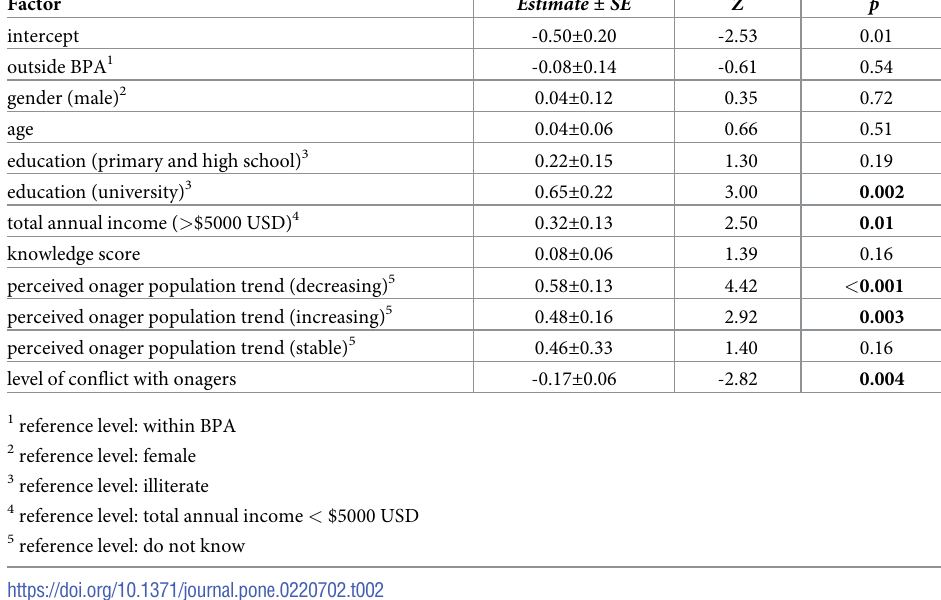
Table 2. Parameter estimates of factors influencing perceived value of onagers resulted from a beta regression model (pseudo R 2 = 0.21, z = 10.96, p < 0.001) for locals within and outside the Bahram-e-Goor Protected Area, Iran. Positive estimates indicate positive association between a factor and perceived value of onagers.